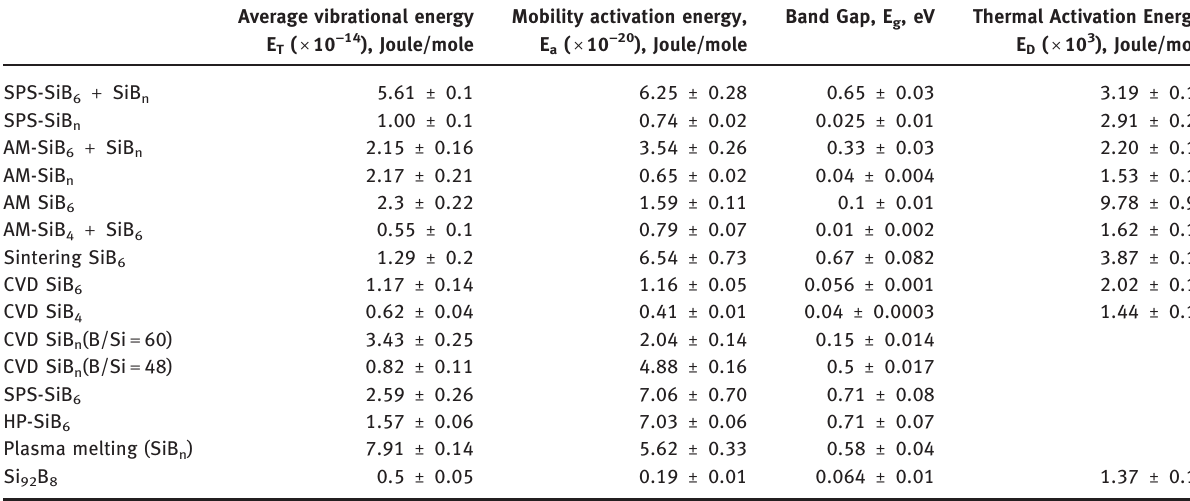
Table 3: Summary of average vibrational energy, band gap, thermal and mobility activation energy. Average vibrational